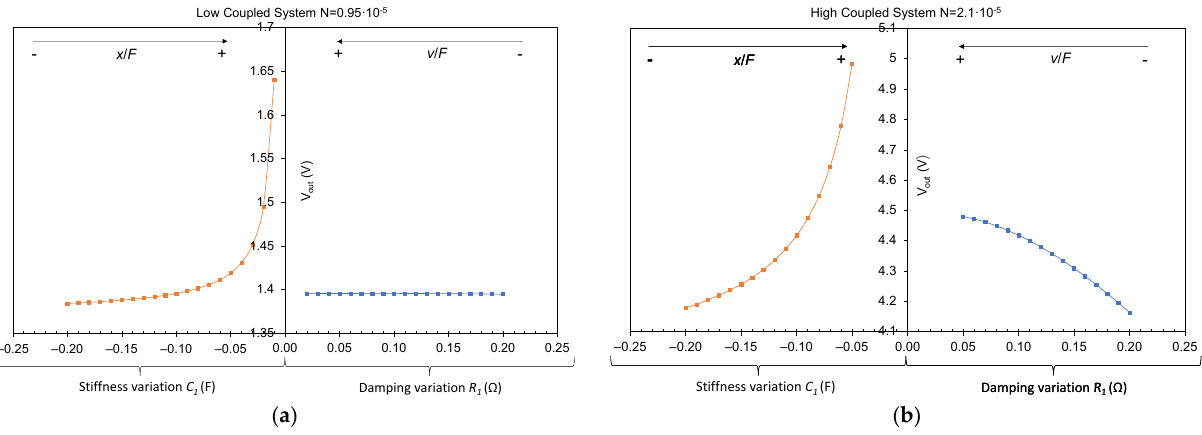
Figure 6. Output RMS voltage obtained in an open circuit scenario evaluated for stiffness and damping variations: ( a ) in low coupled systems; ( b ) in high coupled systems.